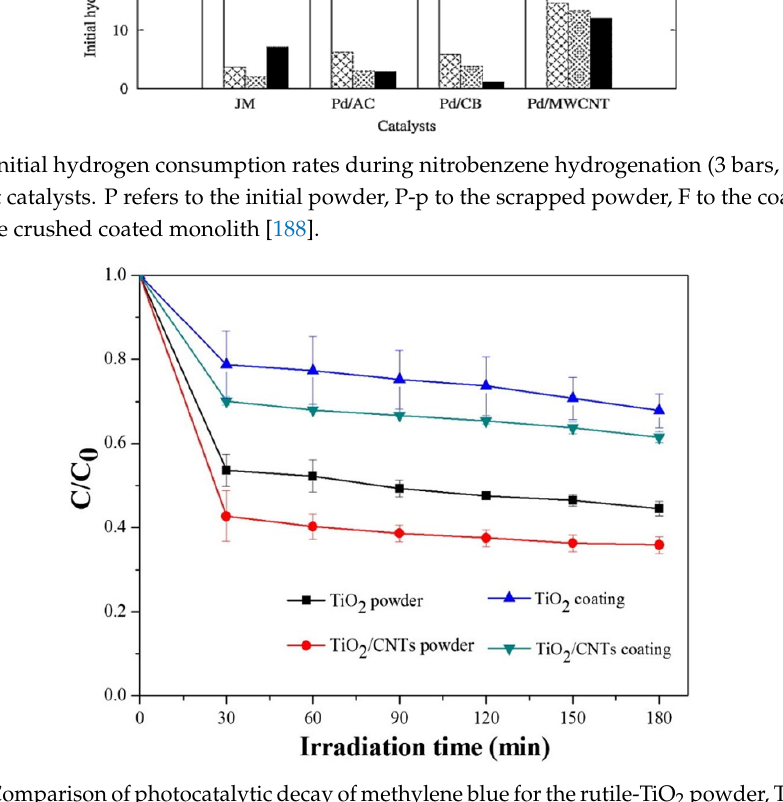
Figure 16. Comparison of photocatalytic decay of methylene blue for the rutile-TiO 2 powder, TiO 2 / CNTs composite powders, TiO 2 coating, and TiO 2 / CNTs composite coating under UV light irradiation at 120 min [235].